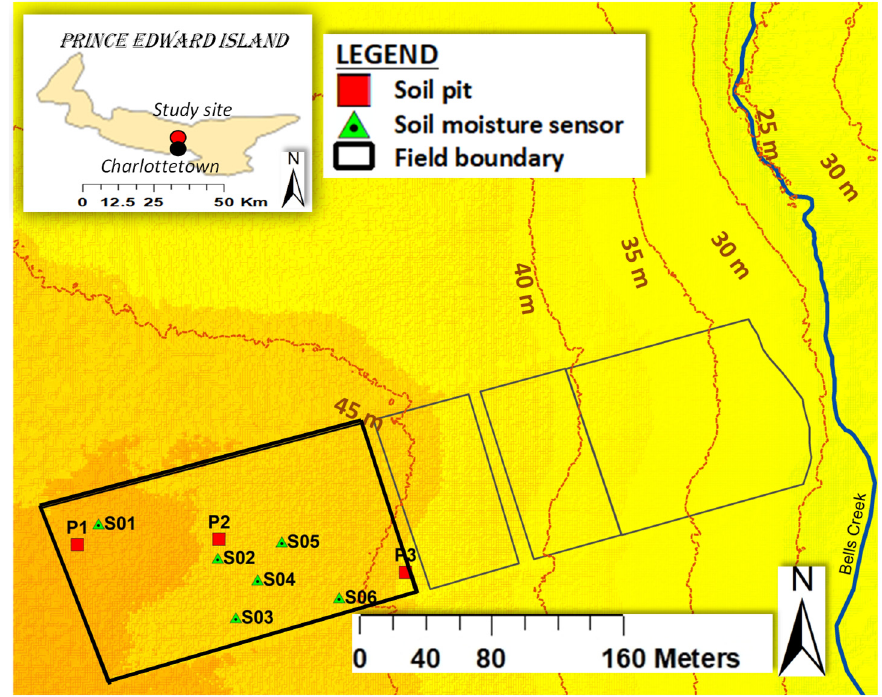
Figure 1. Soil monitoring and sampling locations at the study site. Inset: position of the study site in Prince Edward Island.